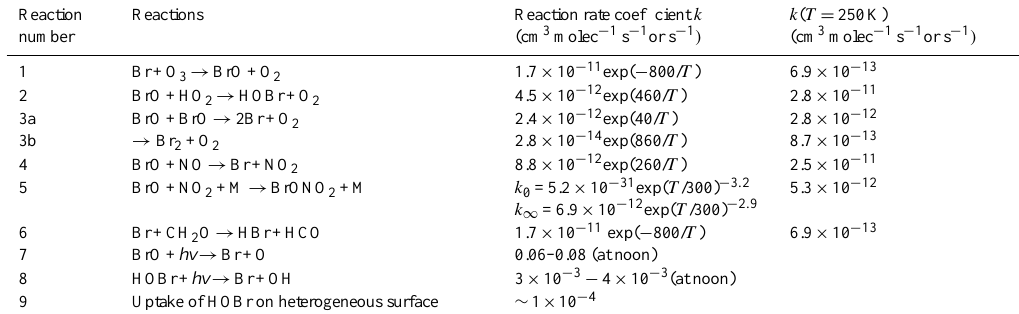
Table 2. Bromine reactions included in the HO x model. Reaction number